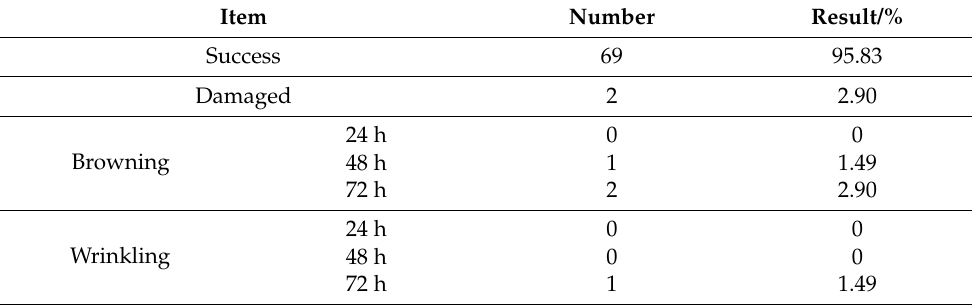
Table 4. Results of picking experiment.